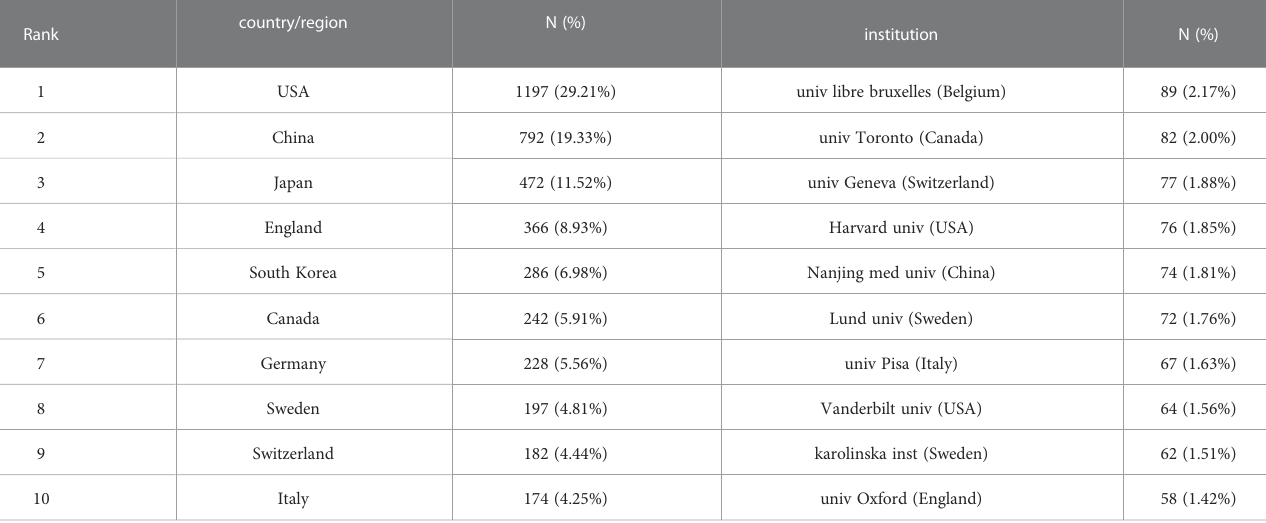
TABLE 1 Top 10 countries/regions and institutions related to beta-cell